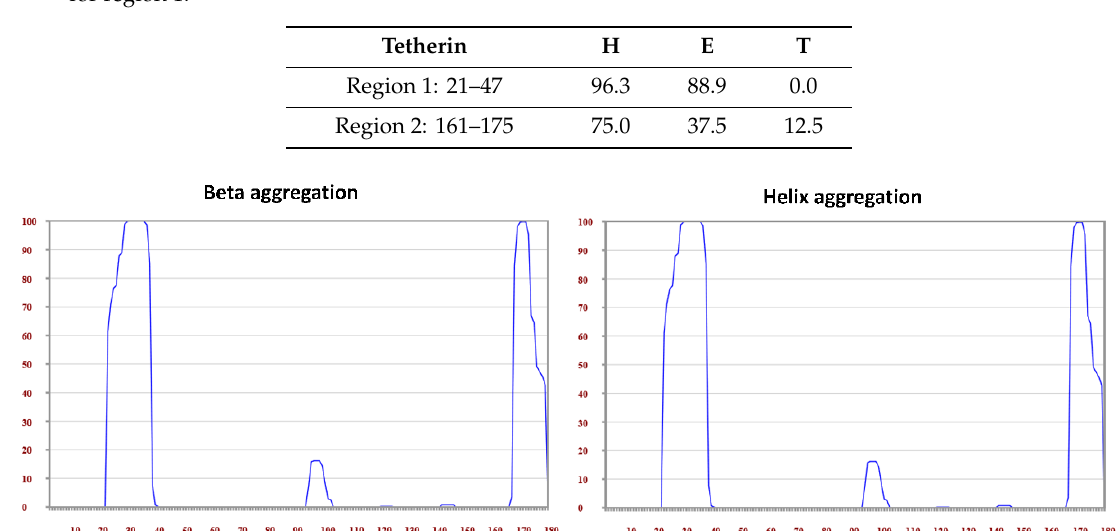
Table 8. Propensity values predicted by Chou–Fasman secondary structure prediction program for amyloid regions in tetherin protein indicating similar propensities for sheet (E) and helix (H) formation for region 1.